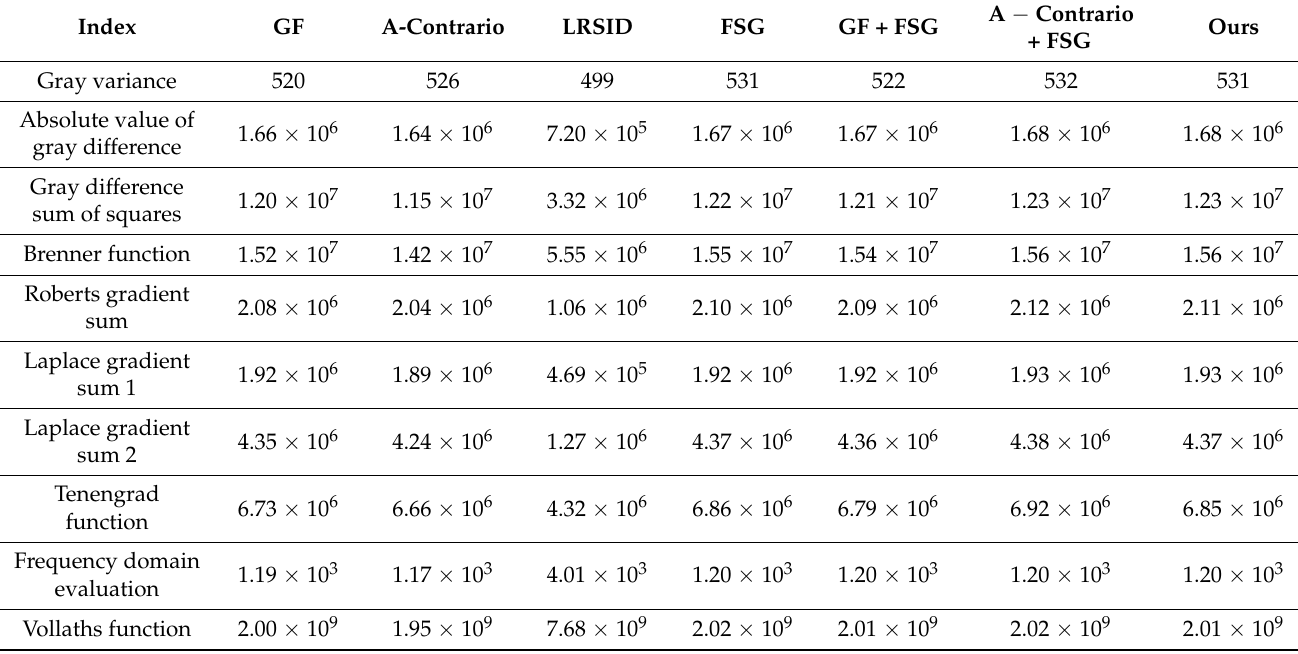
Table 4. Contrast of sharpness index of actual image of thermal imager after stripe